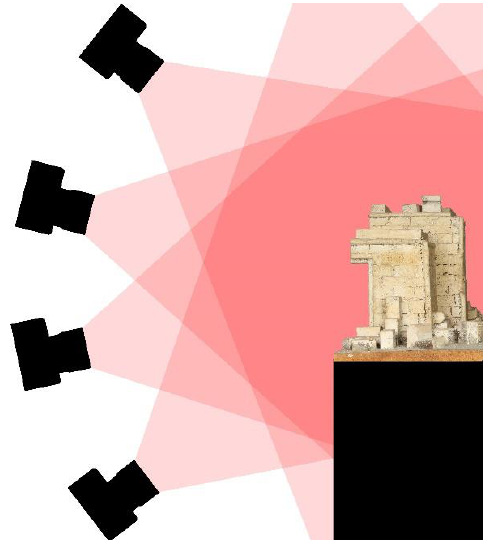
Figure 3. Scheme of the acquisitions (the four assets of the camera can be